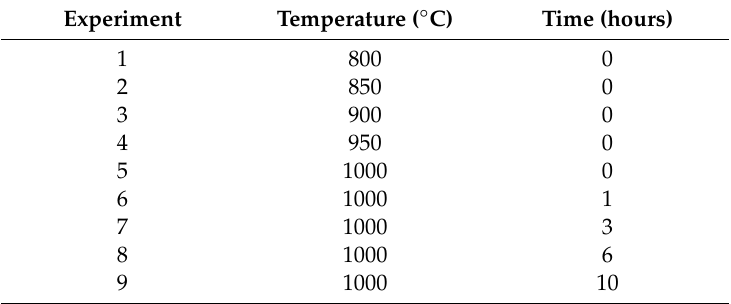
Table 1. Aluminising